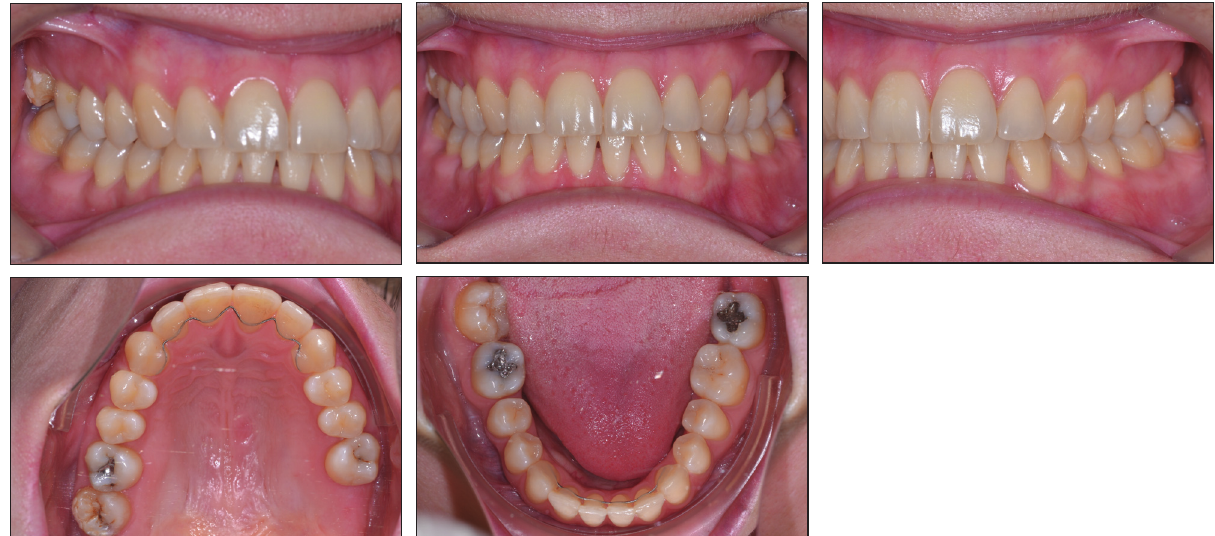
Figure 14. Intra-oral photographs at three years in